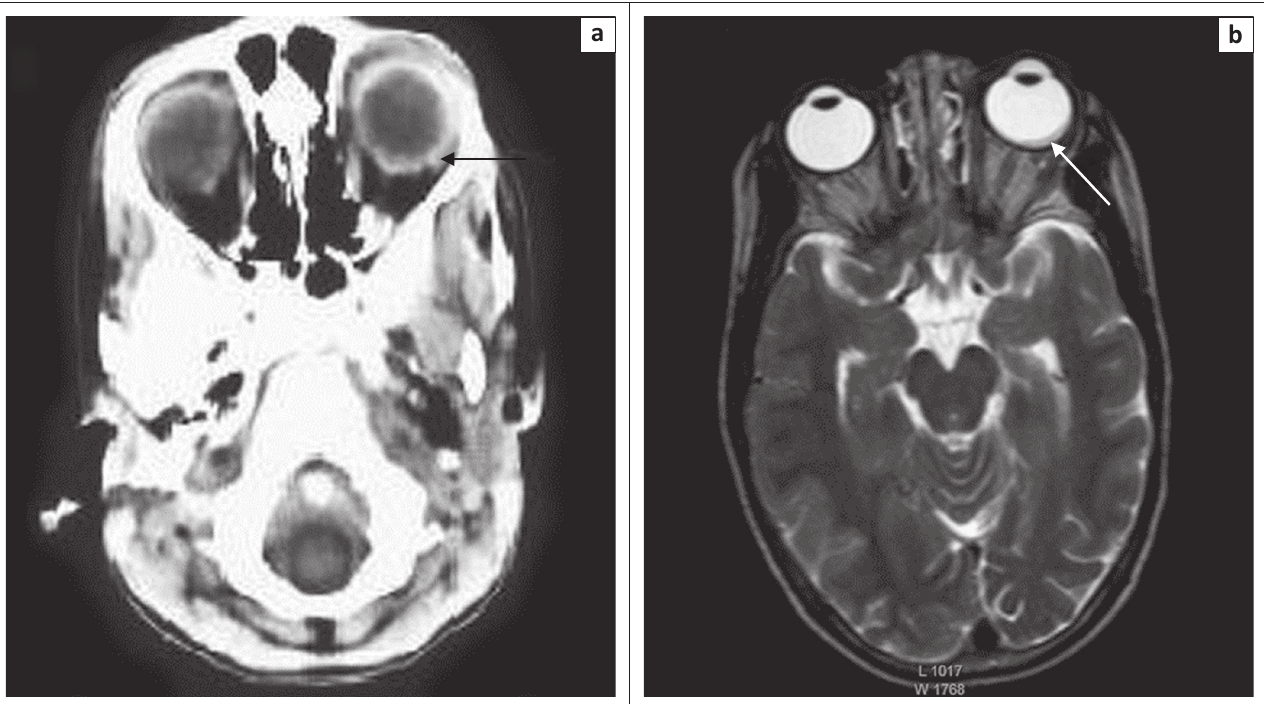
FIGURE 4: Axial NECT (a) and corresponding axial T2WI (b) images demonstrating high density (grey arrow) and low signal (white arrow) respectively along the choroid of the left globe in keeping with a choroidal